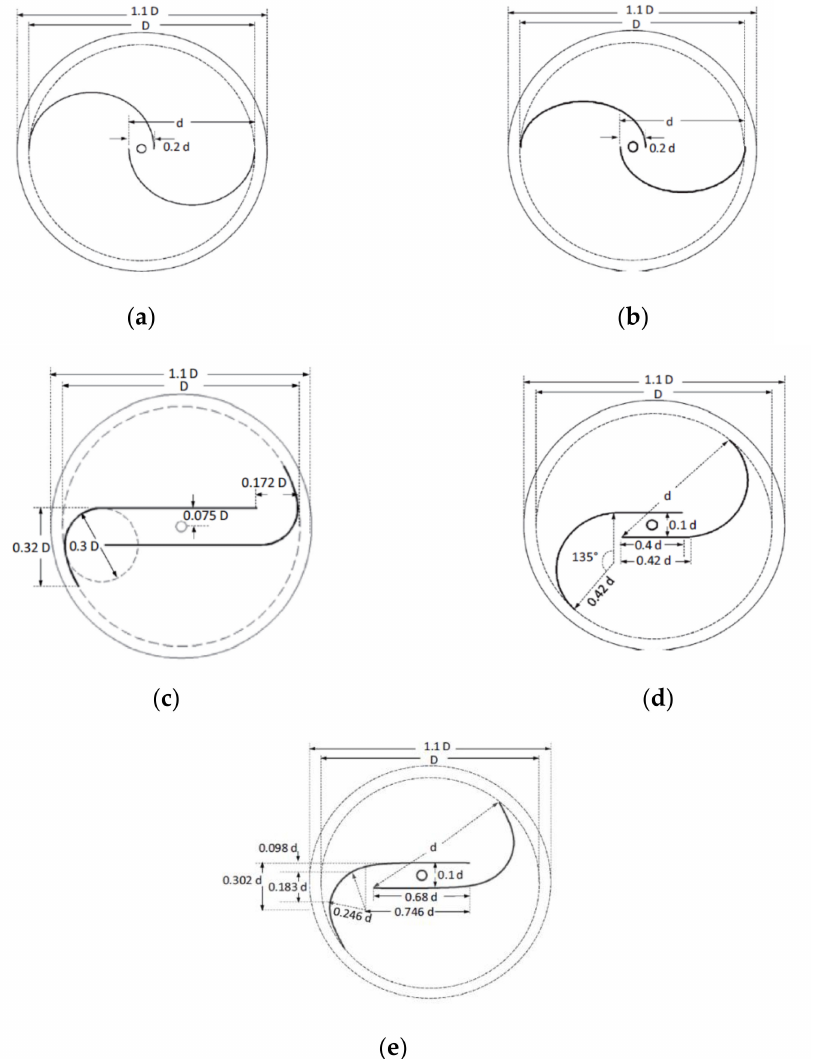
Figure 11. Rotor model profiles analyzed: ( a ) The classical SAVONIUS model; ( b ) The semi-elliptical blade model; ( c ) The Benesh model; ( d ) The modified Bach model; ( e ) The newly developed variant model